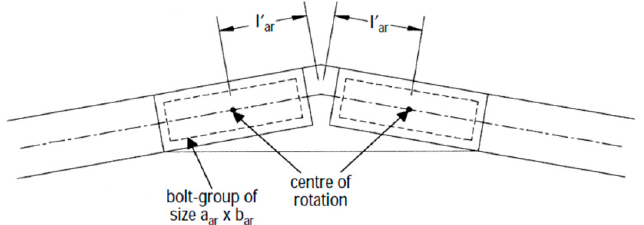
Figure 6. Effective length of apex connection.